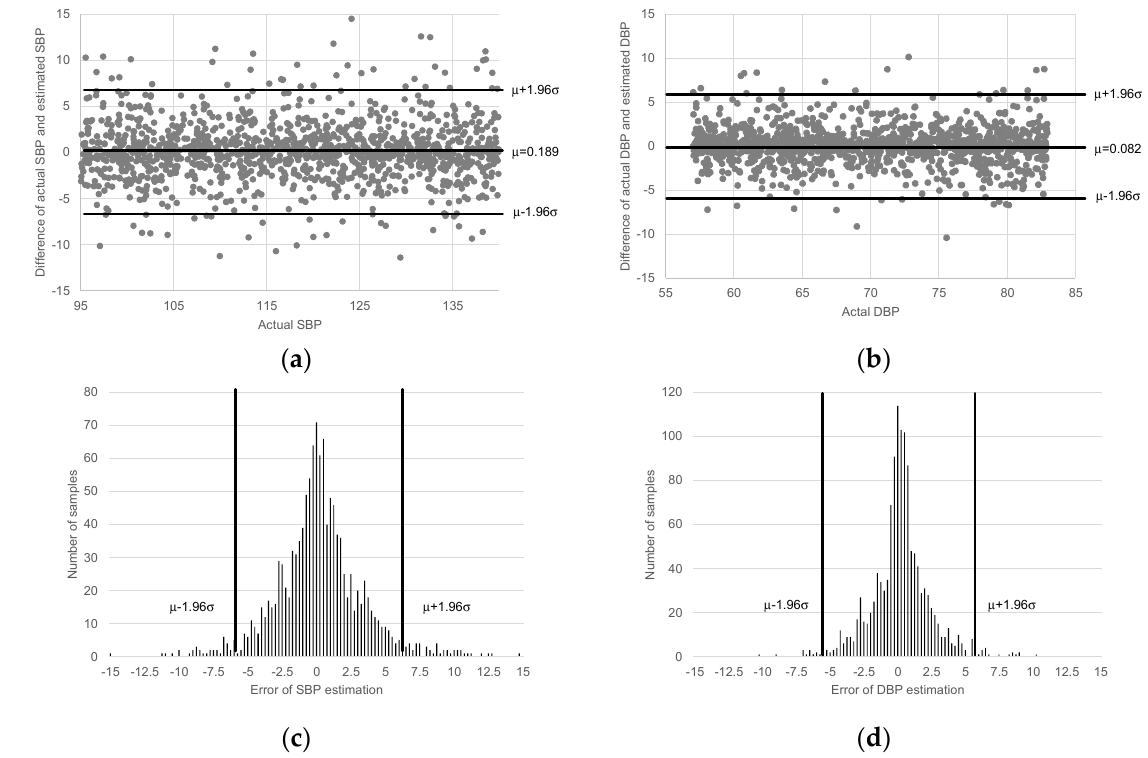
Figure 4. Bland–Altman plots of ( a ) SBP and ( b ) DBP and error distributions of ( c ) SBP and ( d ) DBP.